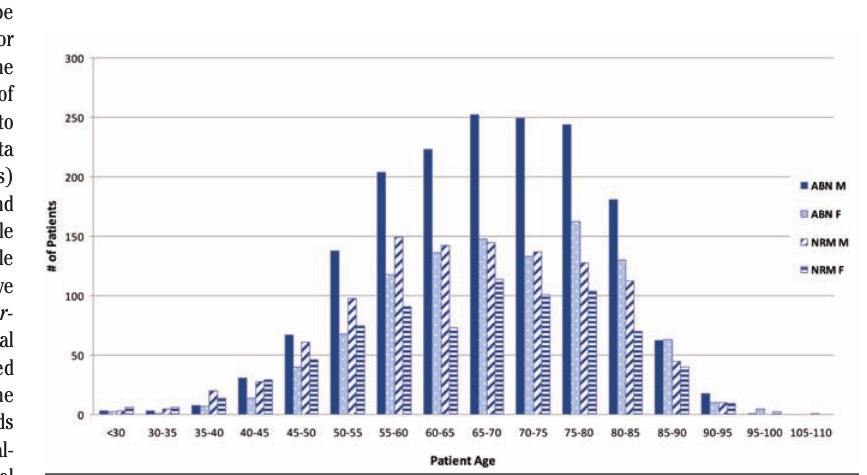
Figure 1. Distribution of the chronic lymphocytic leukemia study population by age and